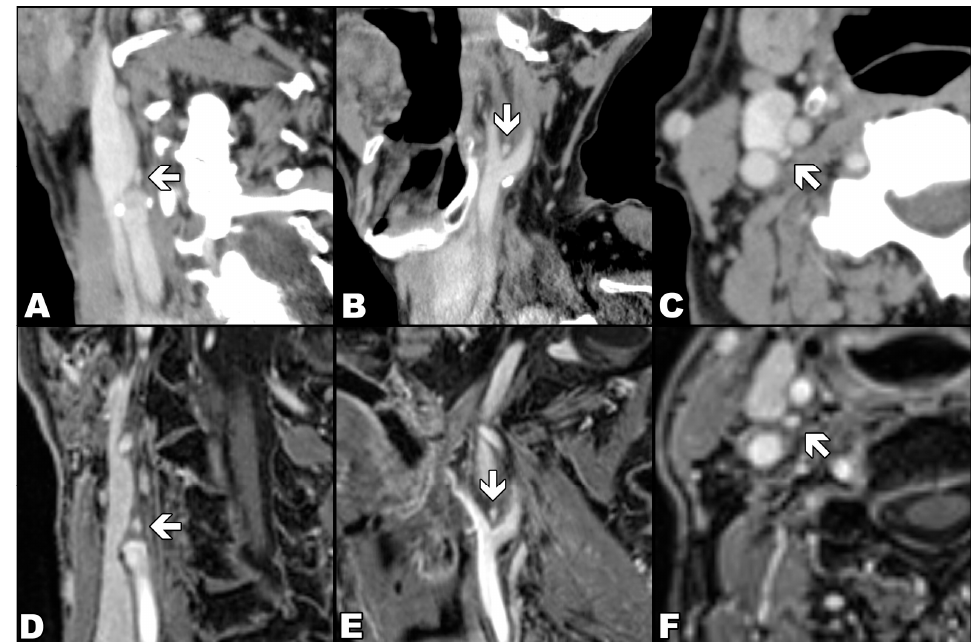
Figure 2. Comparison of the appearance of the carotid body (arrows) in contrast-enhanced computed tomography (upper row) with the appearance in contrasted-enhanced VIBE sequence in T1-weighted image with Dixon technique in the water-only images (lower row). Computed tomography (images ( A – C )) and magnetic resonance (images ( D – E )) examinations show the carotid body in three orthogonal planes: oblique coronal ( A , D ), oblique sagittal ( B , E ) and axial ( C , F ). Table 1. The semi-quantitative confidence scale for assessment of the carotid bodies. Score ROC Threshold Criteria (Both Lists Are Equivalent) 6 Single structure with four typical features 5 Single structure with three typical features Single structure with two typical features OR 4 two structures, one of them with more typical features Single structure with one typical feature OR two structures, both comparable Single structure with no typical features OR three or more comparable structures None structure